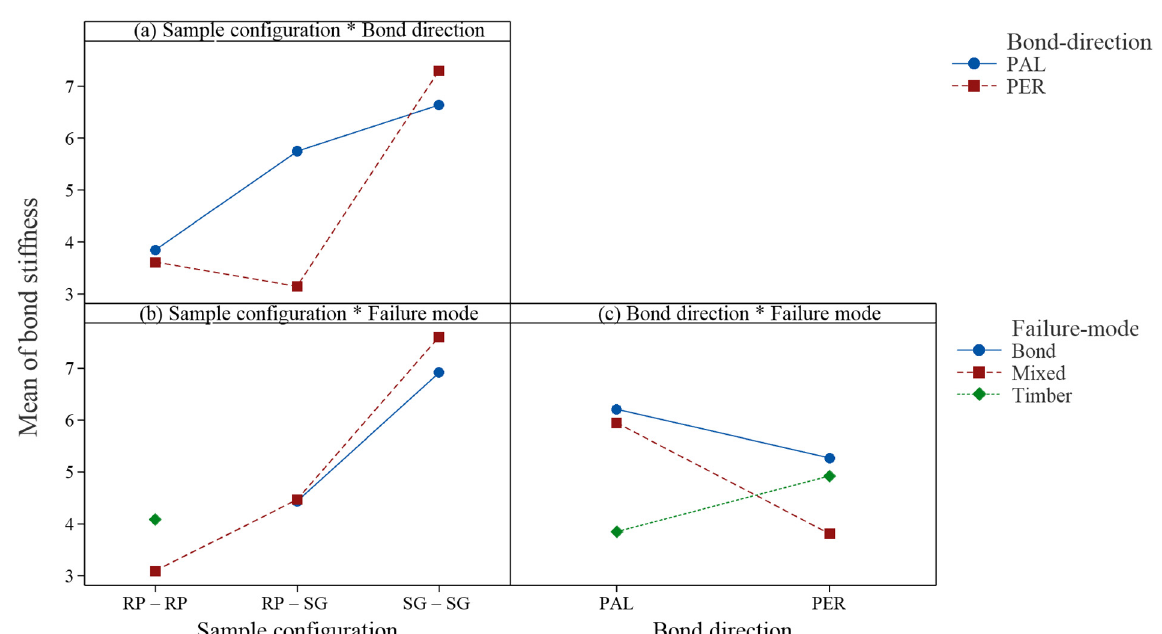
Figure 11. Interaction plot between sample configuration, bond direction and failure mode on bond sti ff ness.